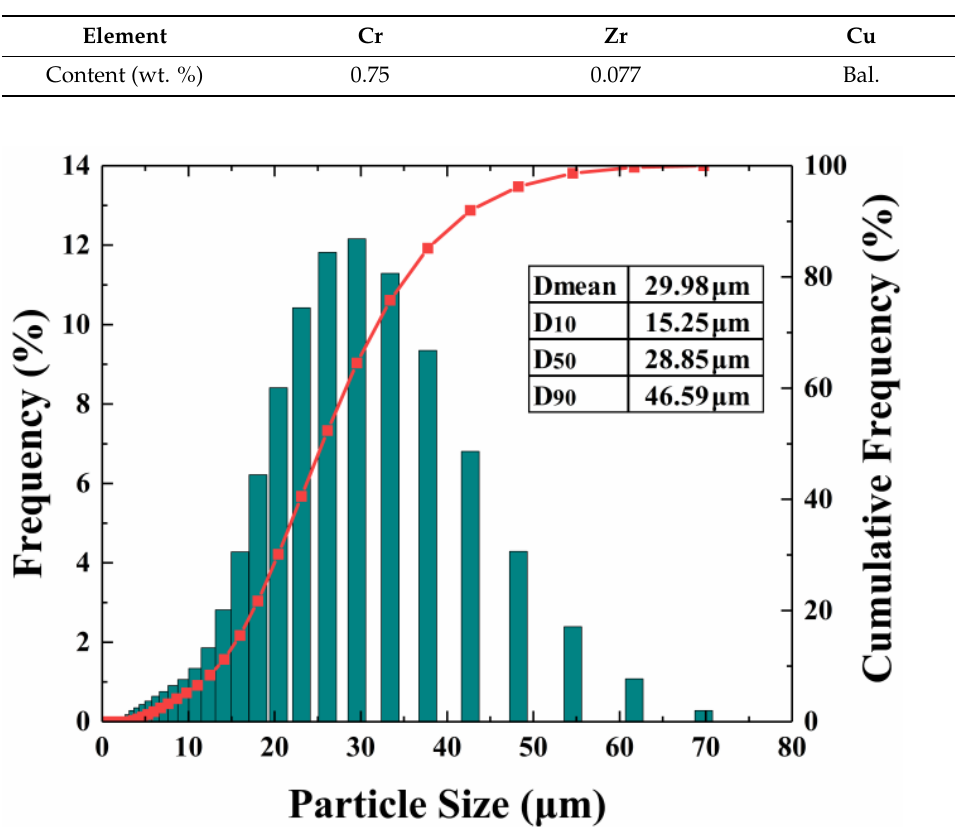
Figure 2. SEM image of CuCrZr powder.